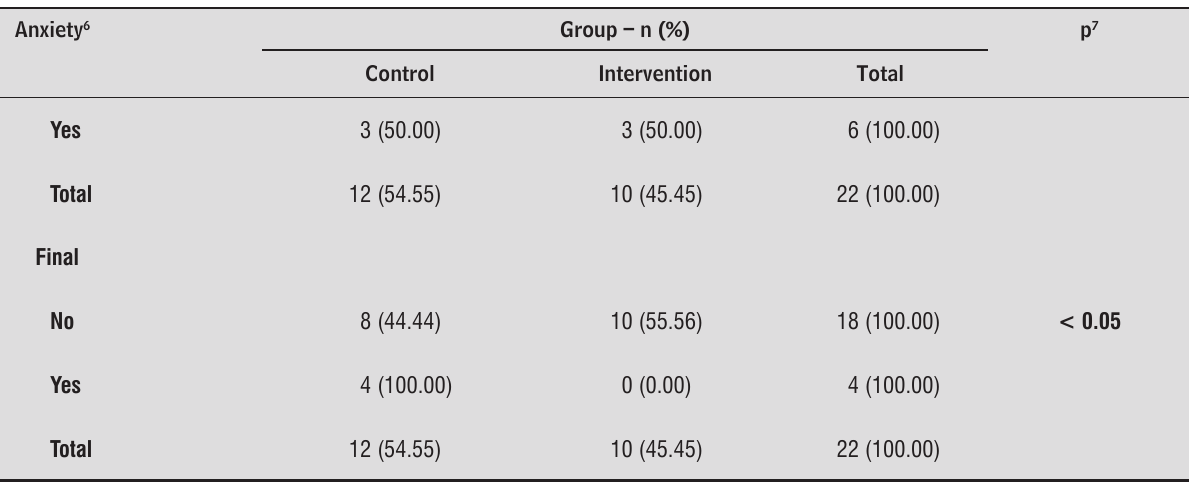
Table 4 - Distribution of occurrence (n) of anxiety in percentages according groups Anxiety 6